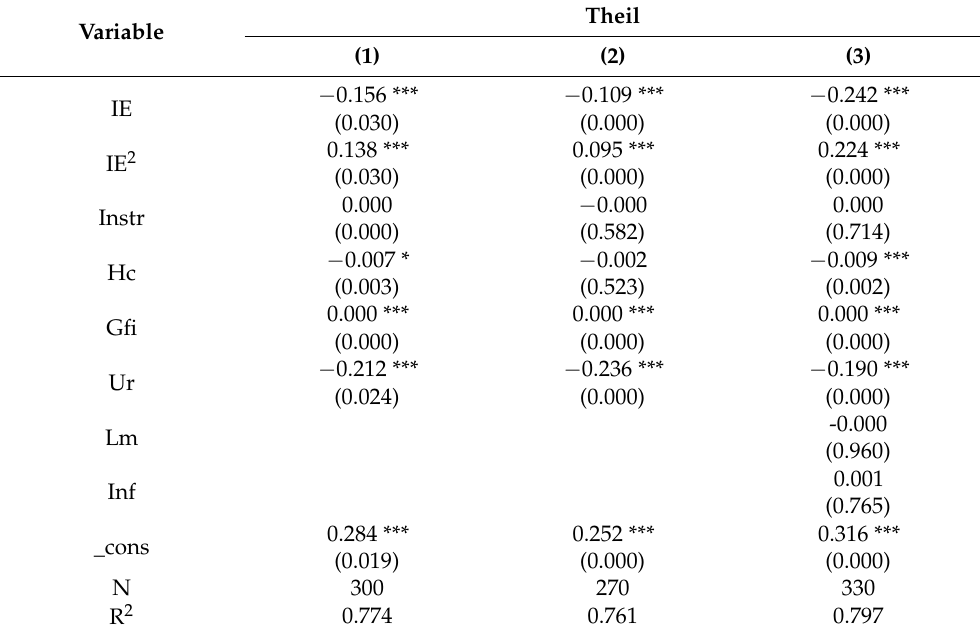
Table 7. Robustness